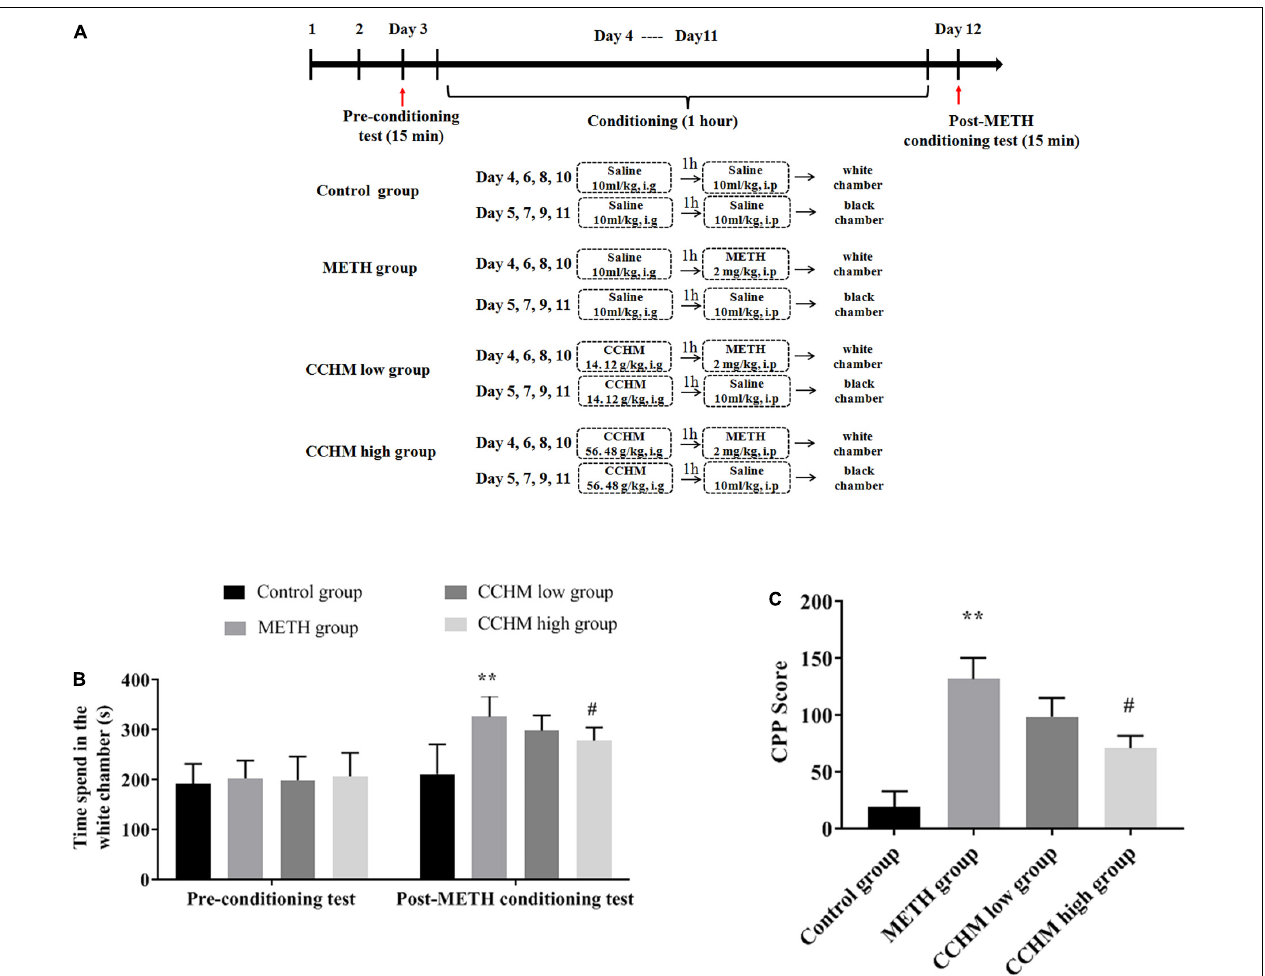
FIGURE 1 | Effect of candidate Chinese herbal medicine (CCHM) on Methamphetamine (METH)-induced conditioned place preference (CPP) in mice. (A) The experiment procedure of CPP test. Mice received METH (2 mg/kg, i.p) or saline (10 ml/kg, i.p) injections following 1 h pretreatments of CCHM (14.12, 56.48 g/kg, i.g) or saline (10 ml/kg, i.g) treatments. (B) Time spent in the white chamber was collected before and after METH abuse. (C) CPP score was calculated by subtracting the time spent in the drug-paired compartment in the pre-conditioning test from that after METH exposure. Data were presented as mean ± SE, ** p < 0.01, compared with control group; # p < 0.05, compared with METH group, n =